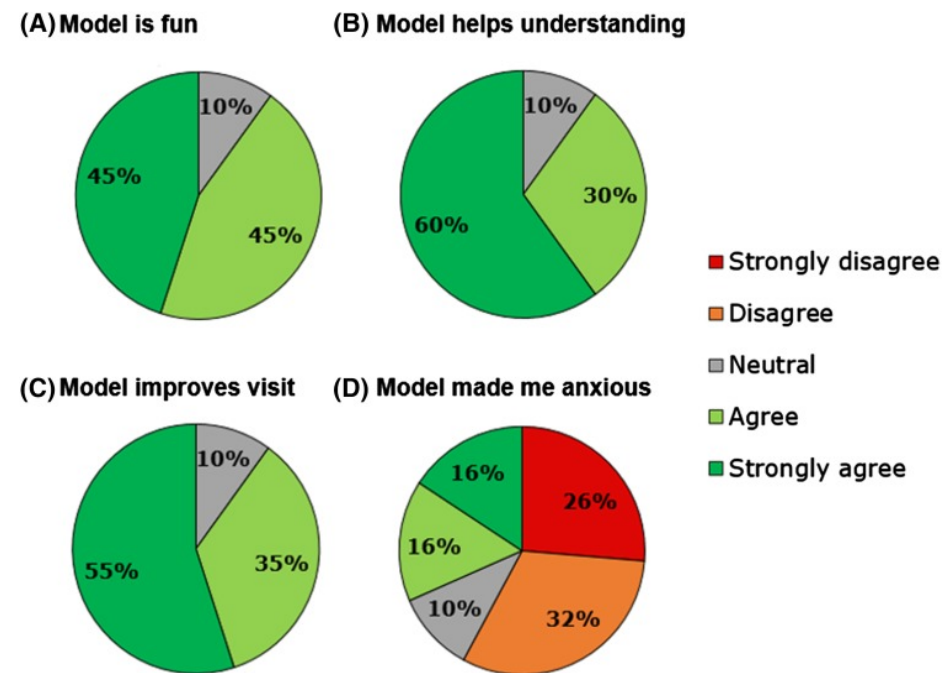
Figure 9. Participants’ response to different statements on the usefulness of 3D printed models. Reprinted with permission under the open access from Biglino et al. [72].